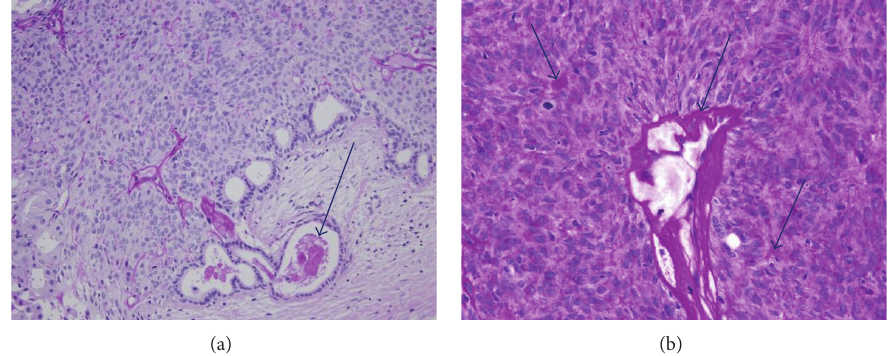
Figure 4: Histopathology of the surgical specimen using Periodic Acid-Schiff (PAS) staining. (a) A mucinous substance showing positive PAS staining was present in the lumen (arrow) (PAS × 100). (b) Dropwise PAS staining was found for a basement membrane-like material within and around alveolar nests in the form of a film (arrow). Deposition of abundant basal lamina material showing PAS staining was also observed (PAS × 200).